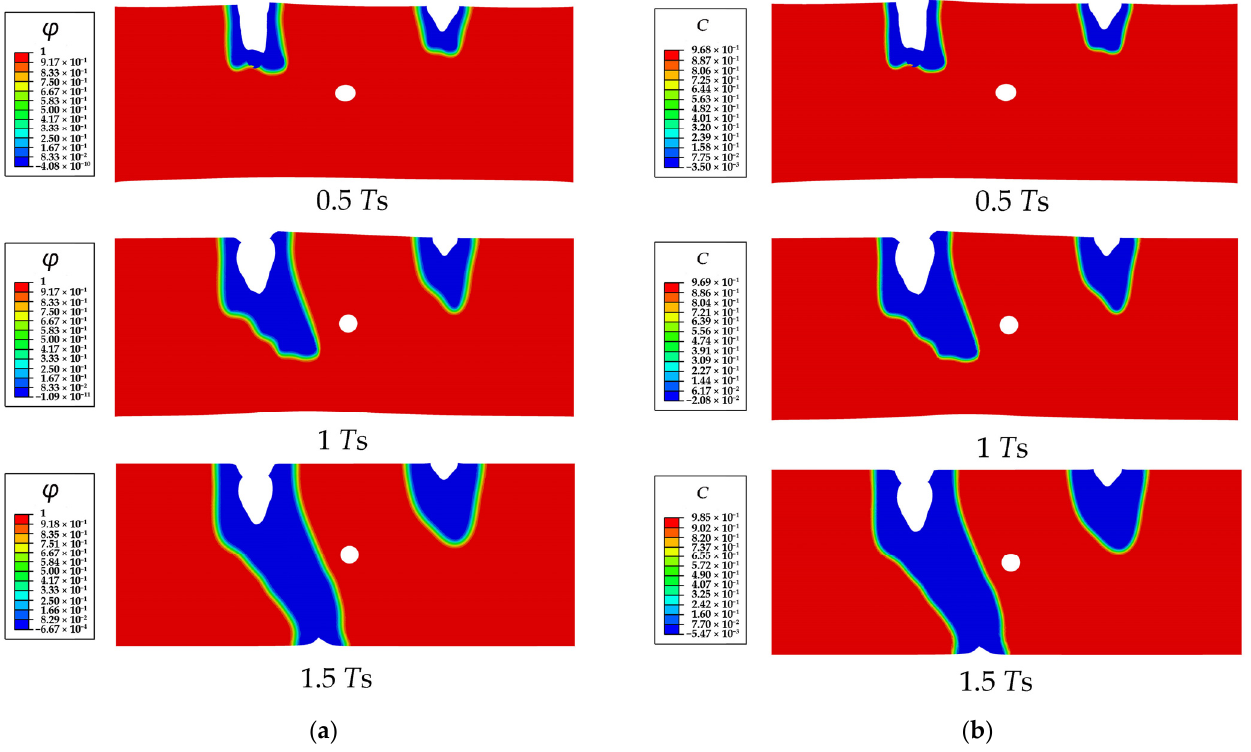
Figure 9. The SCCD process contours of a Mg single crystal with a cavity ( R = 0.1 μ m): ( a ) phase field order parameter ϕ , ( b ) dimensionless concentration c .